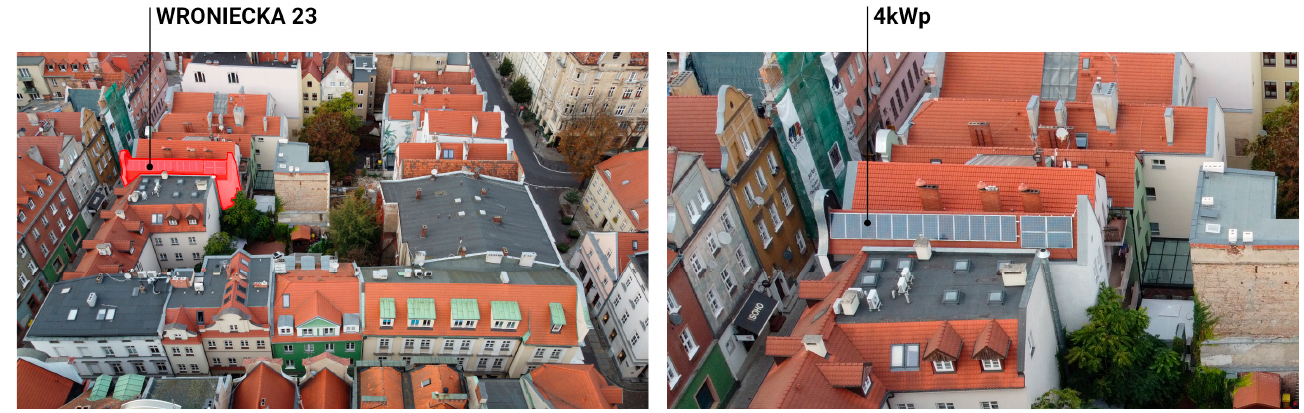
Figure 1. The research building—tenement house at Wroniecka 23, with visible photovoltaic panels having total power of 4 [kWp] (authors’ photos).